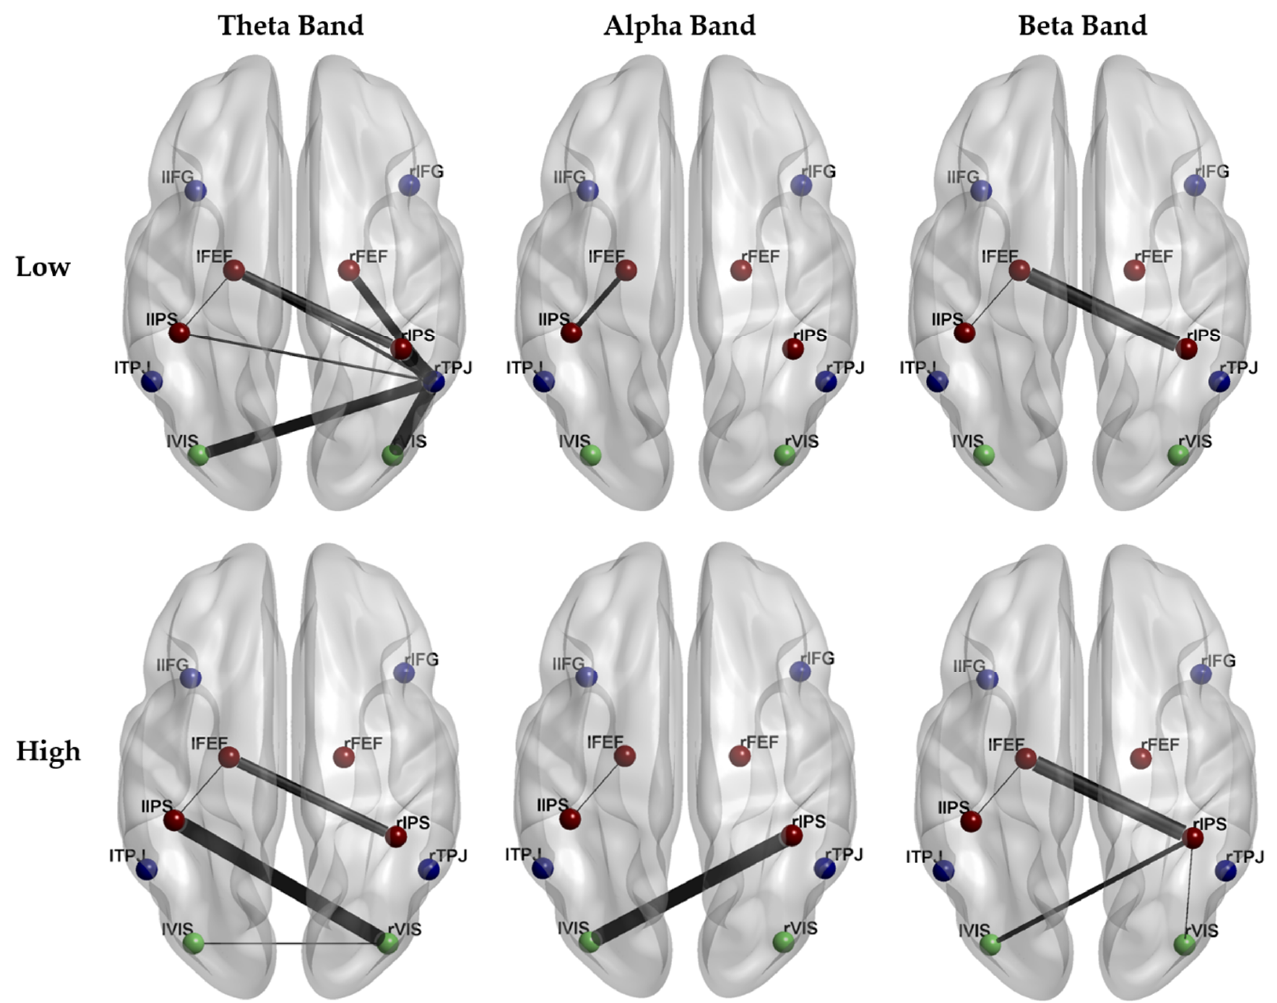
Figure 6. Average over the population of Brain Connectivity Networks in Theta, Alpha, and Beta bands in case of Low and High attentional demand. The thickness of each connection is representative of its weight averaged over the population.